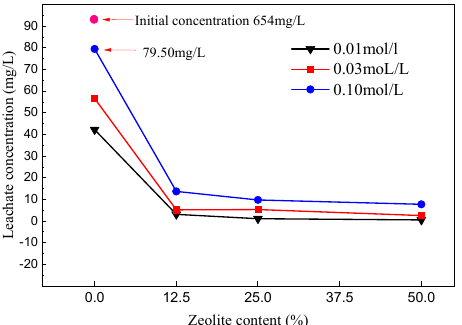
Figure 7. Effect of simultaneous variation of ZnCl 2 concentration stone chip − bentonite − zeolite mixture zeolite admixture on leachate ion concentration.